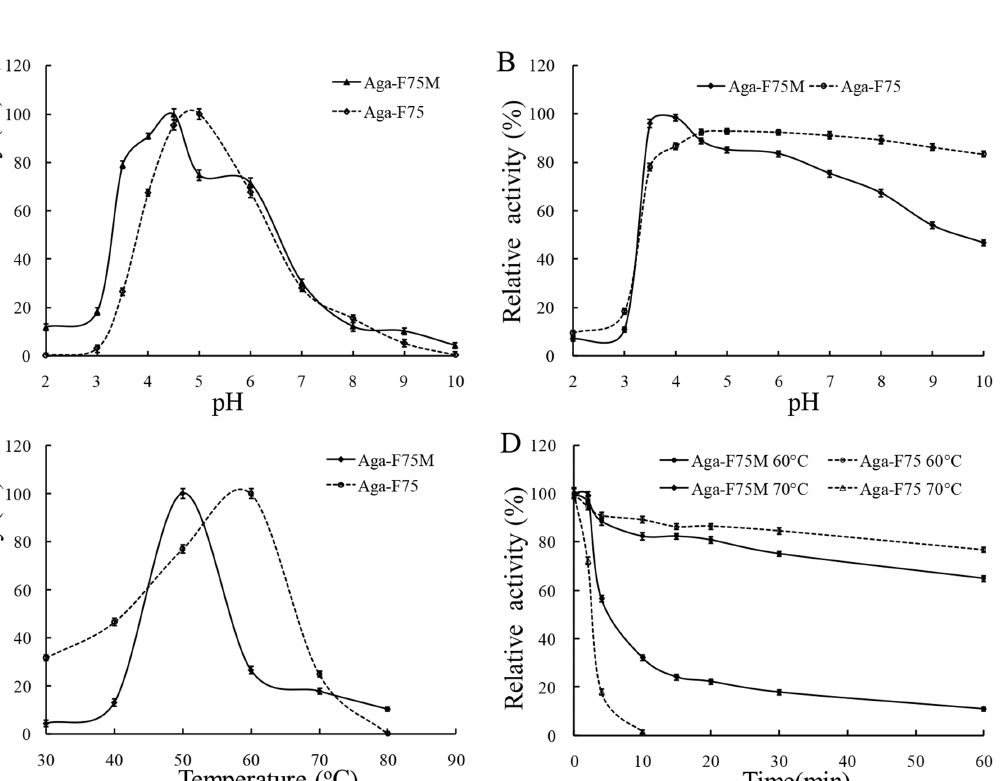
Fig 6. Enzyme properties of recombinant Aga-F75M produced in transgenic maize. (A) Effect of pH on Aga-F75M activity. (B) pH stability of Aga-F75M. (C) Effect of temperature on Aga-F75M activity. (D) Thermostability of Aga-F75M pre-incubated at 60°C or 70°C.